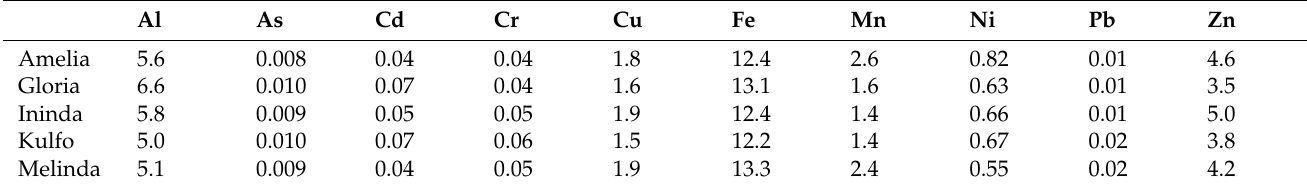
Table 8. Daily Intake of PTEs (DIPTEs, mg) through the intake of 250 g d − 1 (dw) of the studied sweetpotato